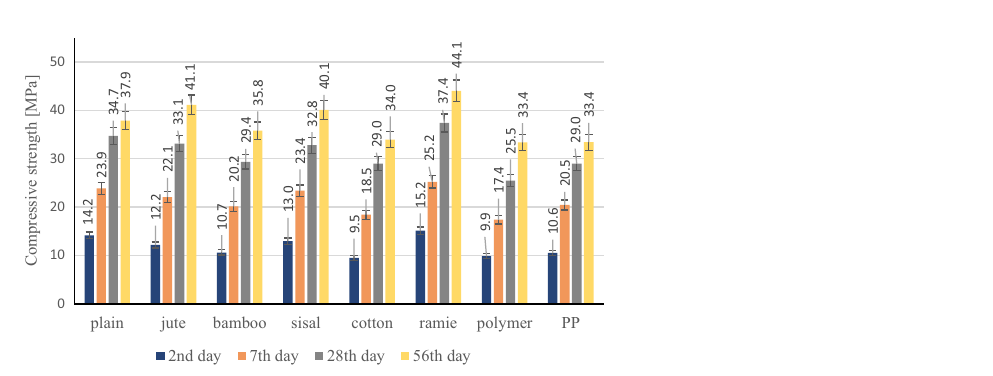
Figure 14. Flexural strength test results.